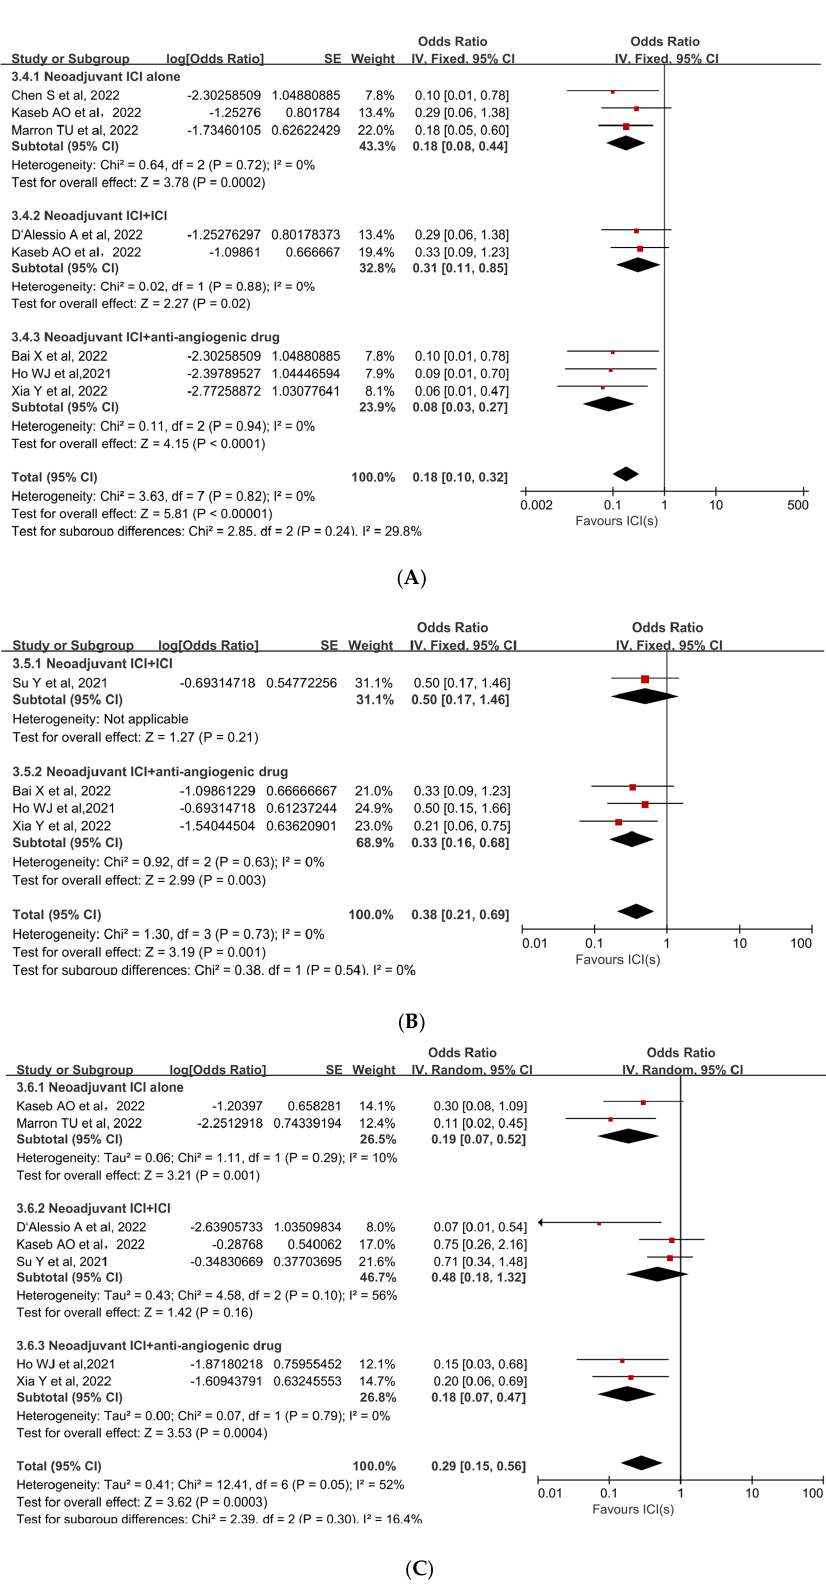
Figure 5. Subgroup analyses based on neoadjuvant immune checkpoint inhibitor combinations for ( A ) pCR, ( B ) MPR, and ( C ) Grade 3−4 TRAEs. ICI: immune checkpoint inhibitor; pCR: pathological complete response; MPR: major pathological response; TRAEs: treatment-related adverse events [31–38].